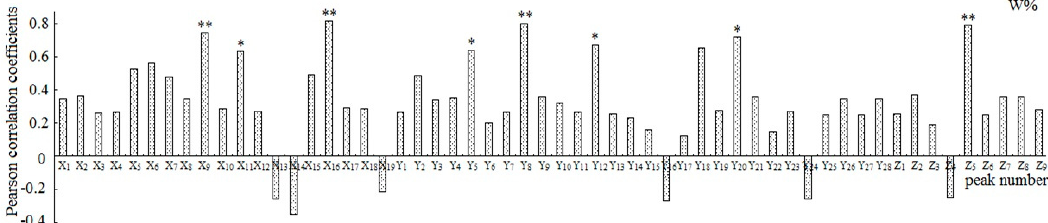
Figure 4. Pearson correlation coefficients between the variables and pharmacologic data W%. **: p < 0.01, *: p < 0.05; W% was the cell proliferation inhibition rate .